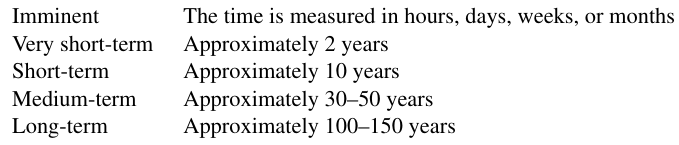
Table 2. Qualitative scale of the level of temporal probability, after the guide of the Laboratoire des Ponts et Chaussées (2004). Imminent The time is measured in hours, days, weeks, or months Very